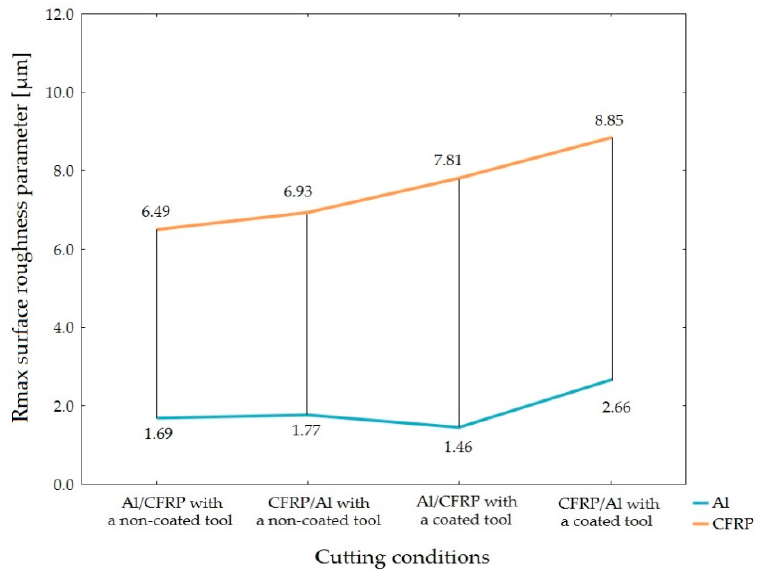
Figure 13. Surface uniformity based on the value of Rmax surface roughness parameter obtained depending on the machining configuration and the type of tool.